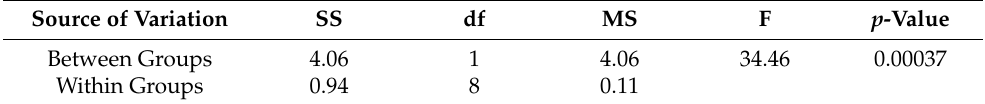
Table 6. ANOVA analysis for the flexural